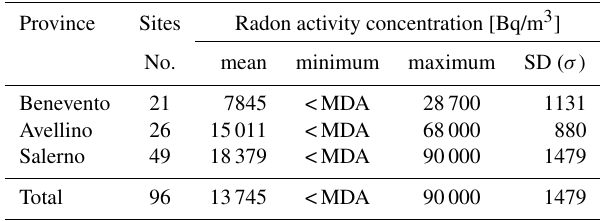
Table 1. Measured values of radon activity concentrations in soil- gas.